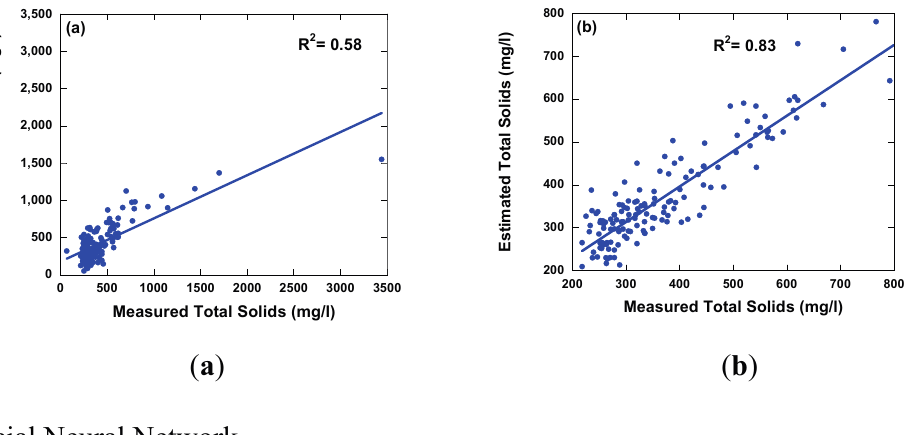
Figure 6. The relationship between measured TS from in situ sampling and estimated turbidity derived from field spectral using multiple regression equation. ( a ) all data; ( b ) exclude above 800 mg·L − 1